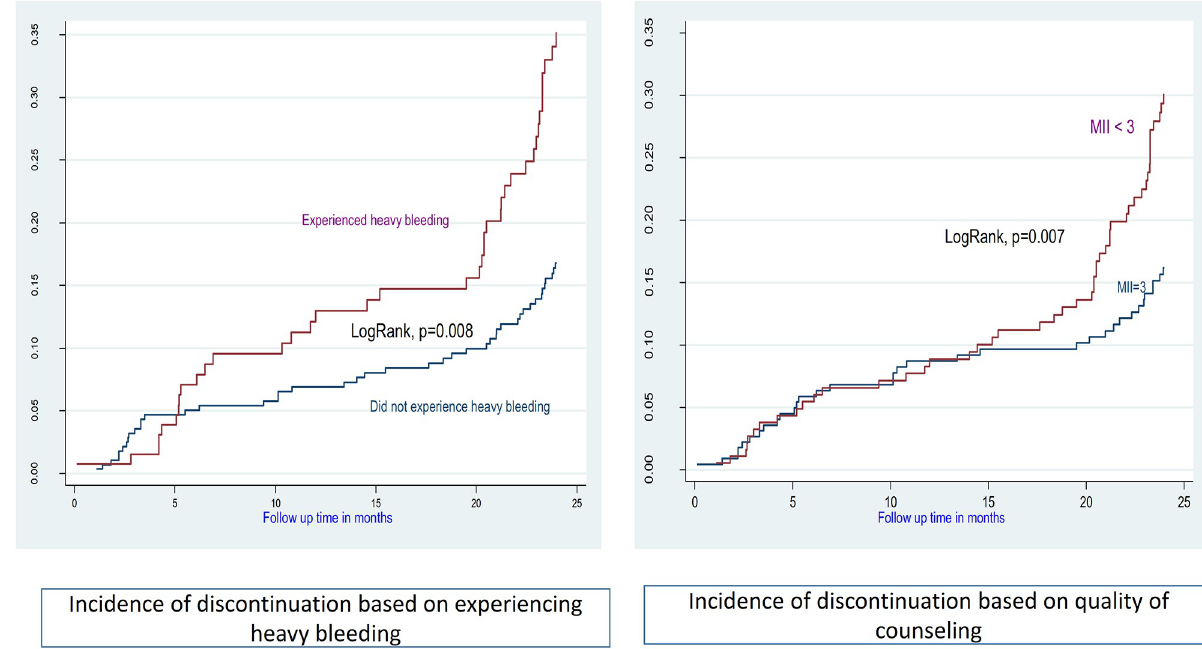
Fig 3. Incidence of discontinuation based on bleeding pattern and quality of counseling.